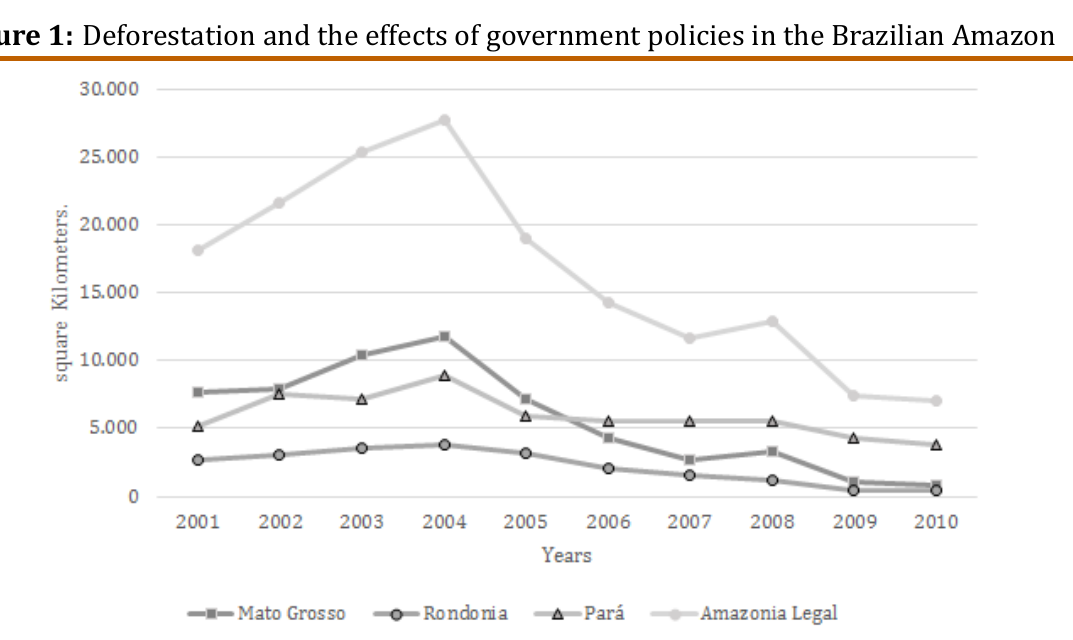
Source: Prepared by CASTELO (2015) from PRODES/INPE,